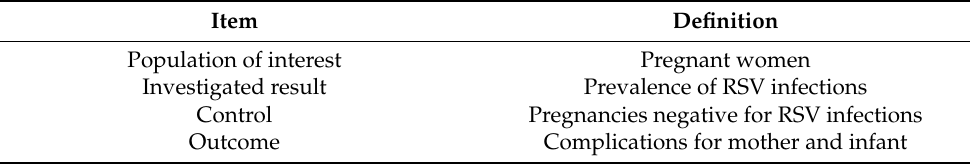
Table 4. PICO worksheet (note: RSV = respiratory syncytial virus). Item Definition Population of interest Pregnant women Investigated result Prevalence of RSV infections Control Pregnancies negative for RSV infections Outcome Complications for mother and